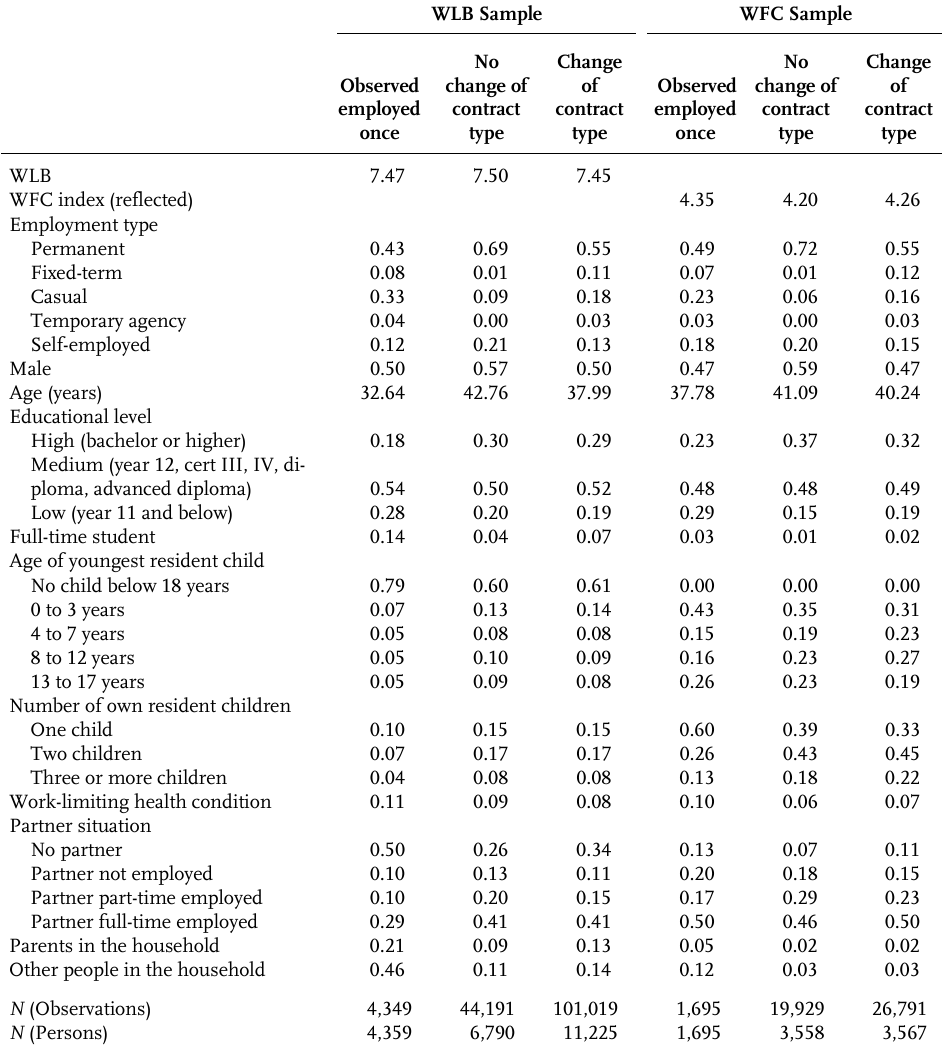
Table A.2 : Characteristics of sample members by times observed in employment and whether employment type changed (means based on total person-year